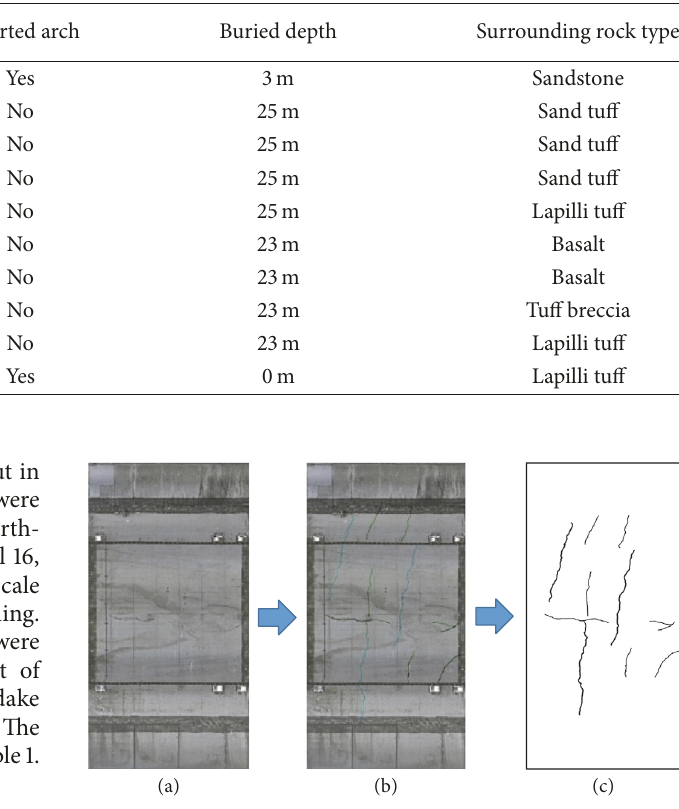
Figure 4: Extraction of cracks on tunnel lining surface: (a) unfolded crack image; (b) identification of cracks; (c) extraction of cracks. Table 2: Tunnel-lining crack index of the ten studied